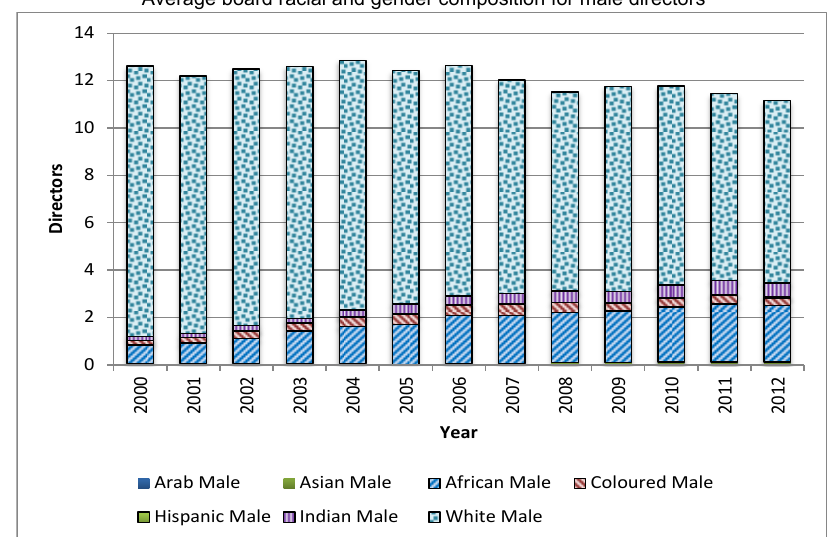
Average board racial and gender composition for male